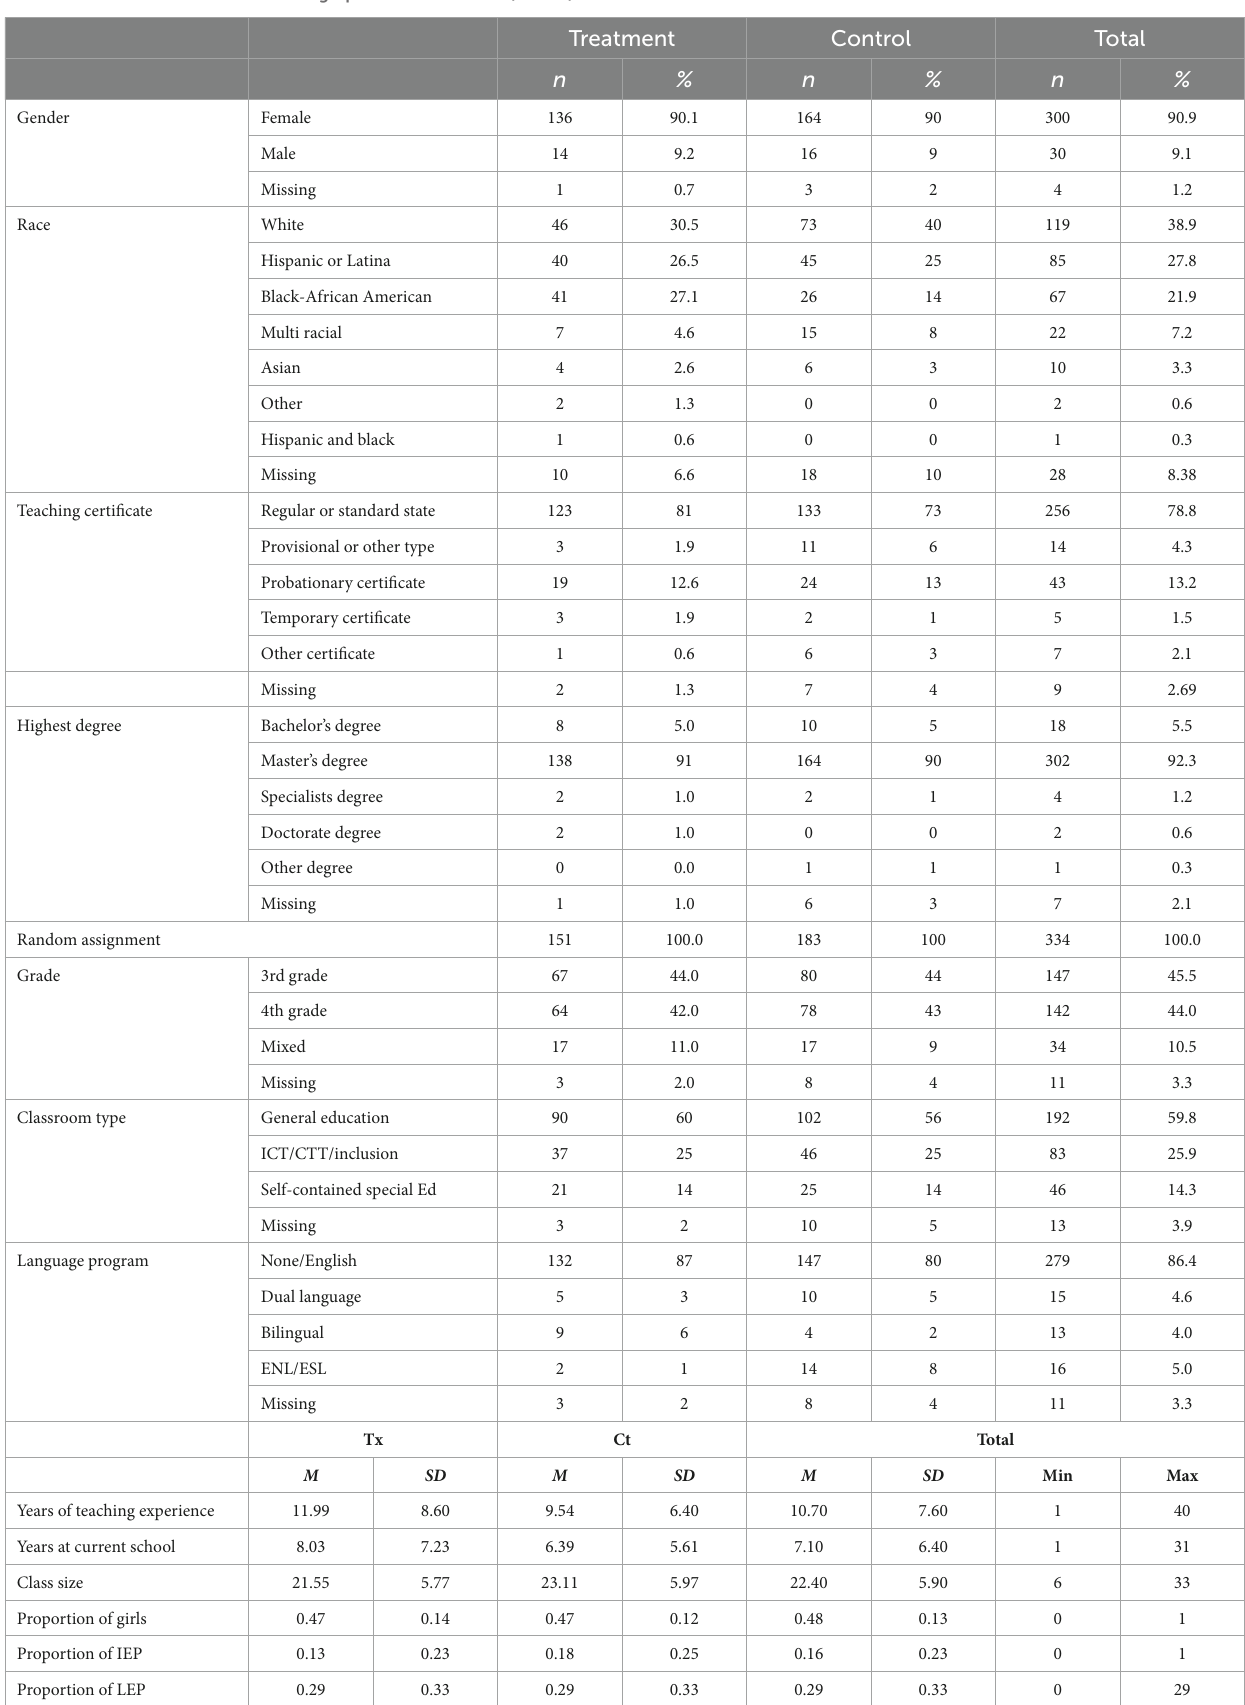
TABLE 1 Teacher and classroom demographic characteristics ( n =